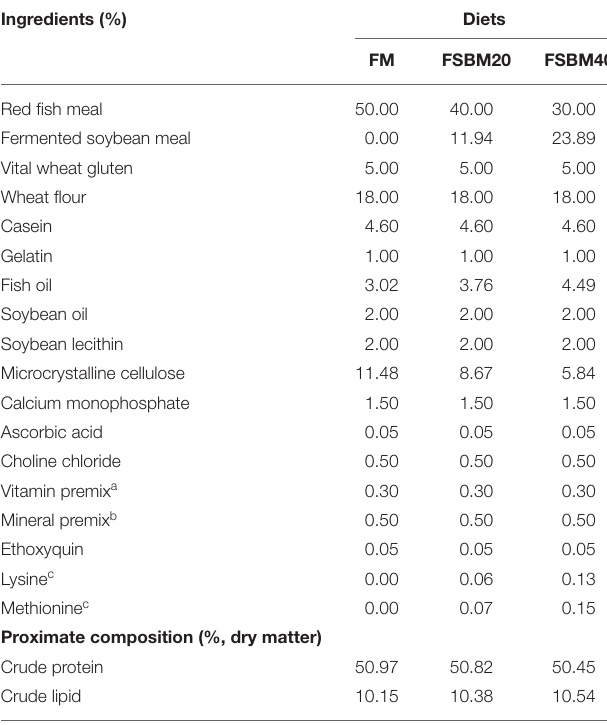
TABLE 1 | Formulation and proximate composition of the experimental diets (%, dry matter). Ingredients